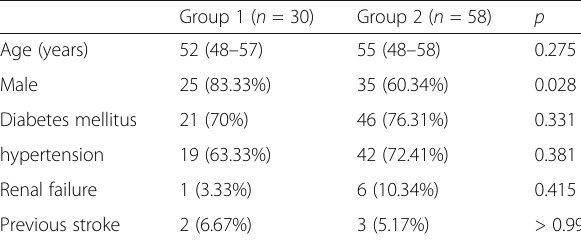
Table 1 Preoperative patient ’ s